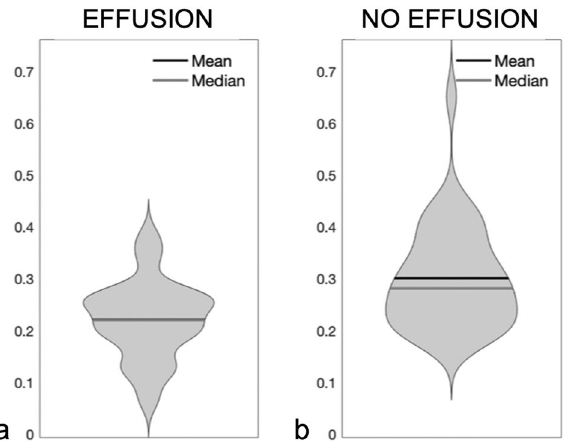
Figure 7. Violin plots presenting the differences in average intensity between ears with middle ear effusions and those without. ( a ) Ears with effusions had average lower intensity compared to ( b ) ears without effusions.